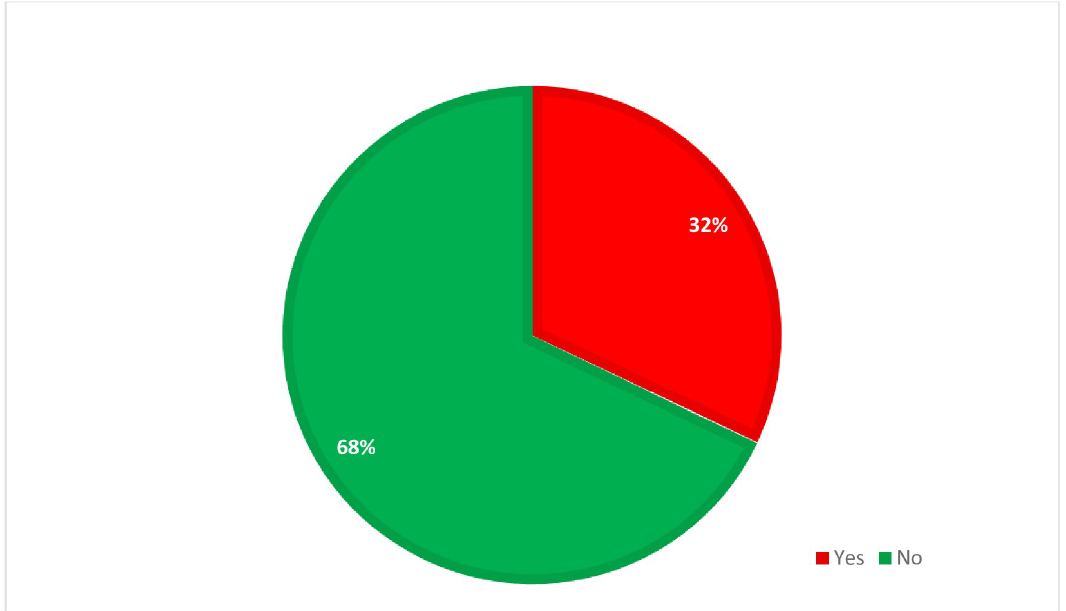
Fig 3. Magnitude of acute respiratory distress syndrome reported among severe COVID-19 patients included in the study at WURH, 2021.